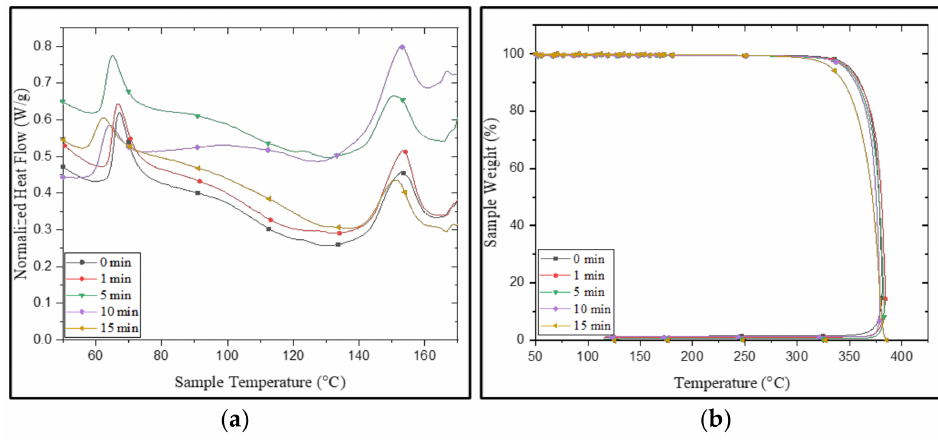
Figure 6. ( a ) DSC and ( b ) TGA of PLA non-UV- and UV-irradiated tubes. The bi-axial stretching with a smaller dosage of UV exposure increased the